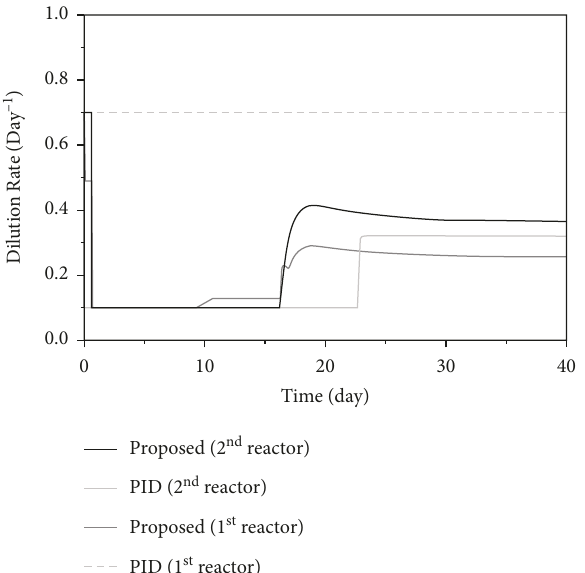
Figure 7: Dilution rate profiles corresponding to the closed-loop system of Figure 5.